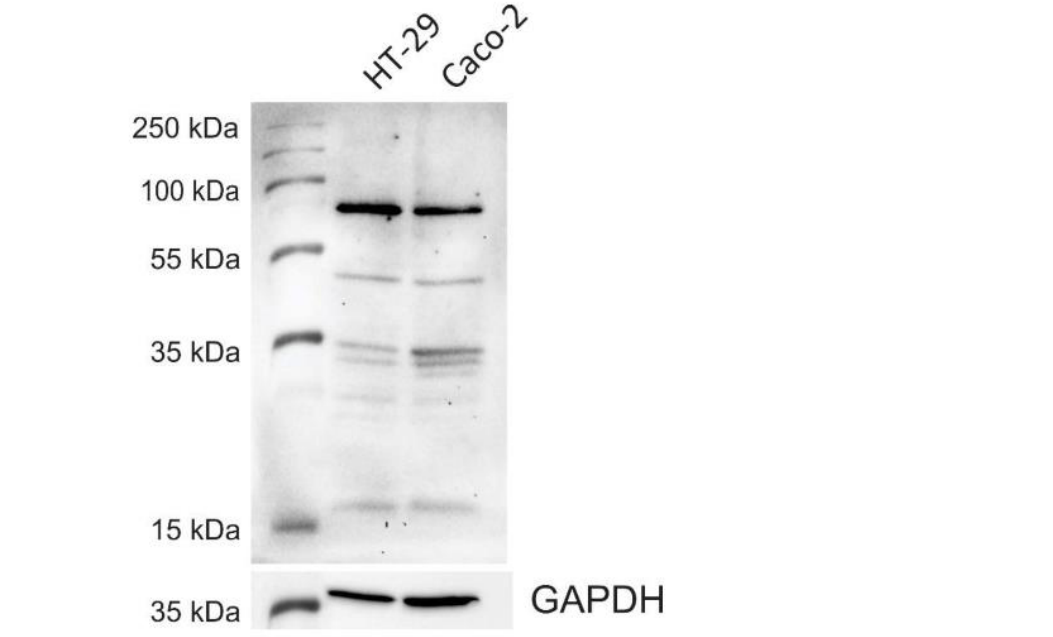
Figure 1. A Western blot showing the Clitocybe nebularis lectin-mediated recognition of glycopro- teins in HT-29 and Caco-2 cell lysates. GAPDH was used as a loading